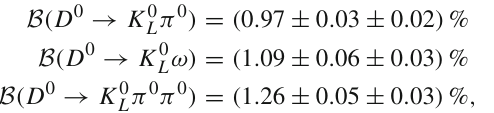
distributions of D → K 0 miss